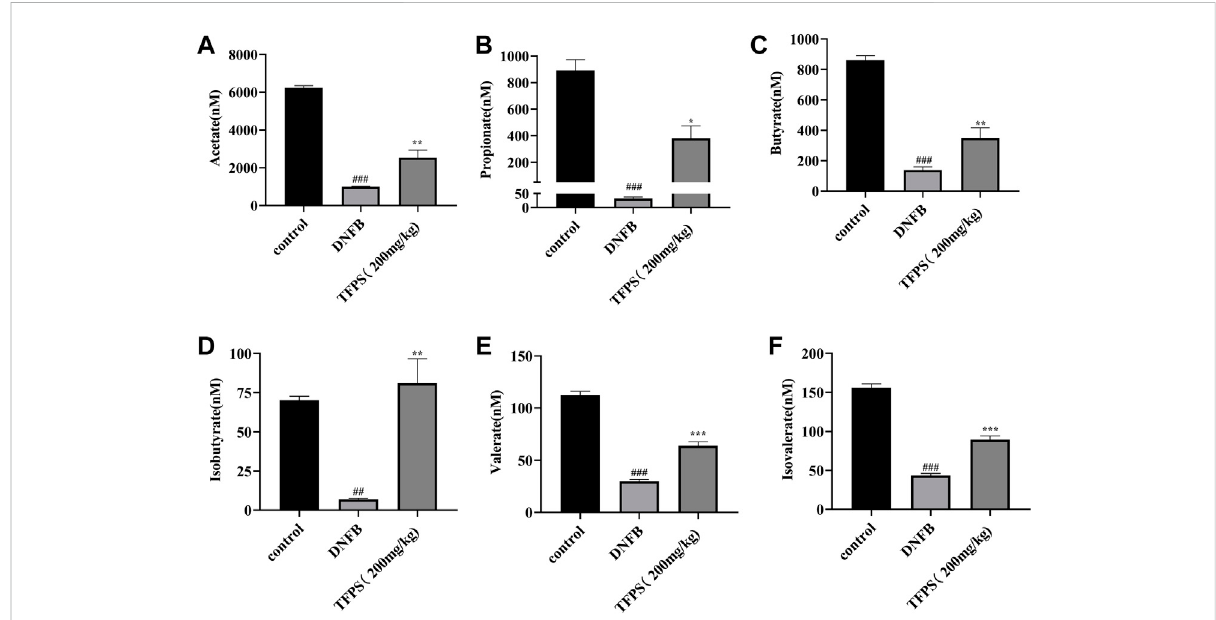
FIGURE 11 ChangesofSCFAsbyTFPStreatmentinDNFB-inducedADmice. (A) Measurementofconcentrationsofacetate (A) ,propionate (B) ,butyrate (C) , isobutyrate (D) , valerate (E) and isovalerate (F) in control-, DNFB induction- and TFPS treatment groups, respectively. All values are presented as means ± S.E.M ( n = 3). ## p < 0.01, ### p < 0.001 compared with thecontrol group; p p < 0.05, pp p < 0.01, ppp p < 0.01compared with the model